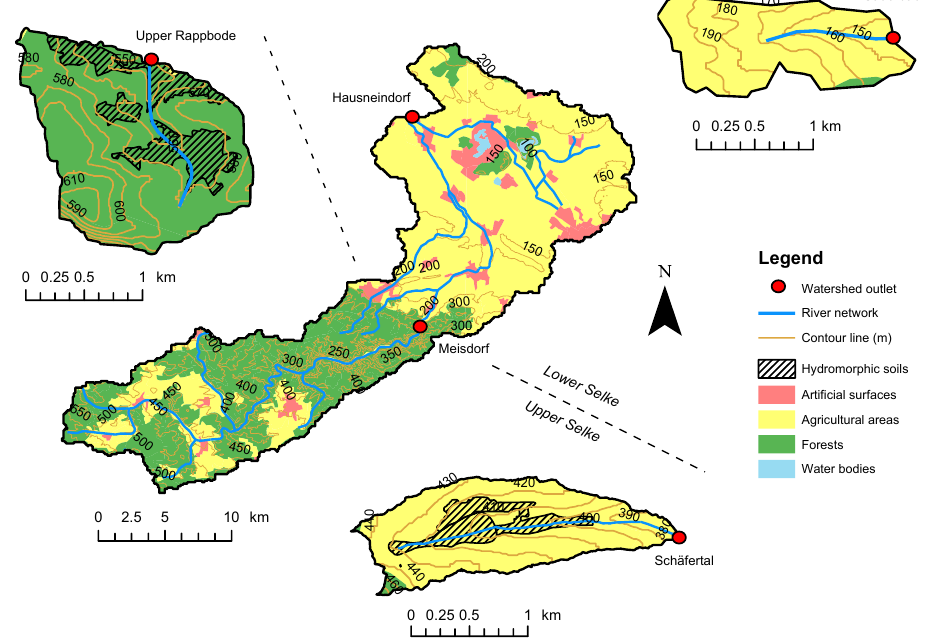
Figure 1. Landscape types in the Selke catchment and location of monitoring sites.